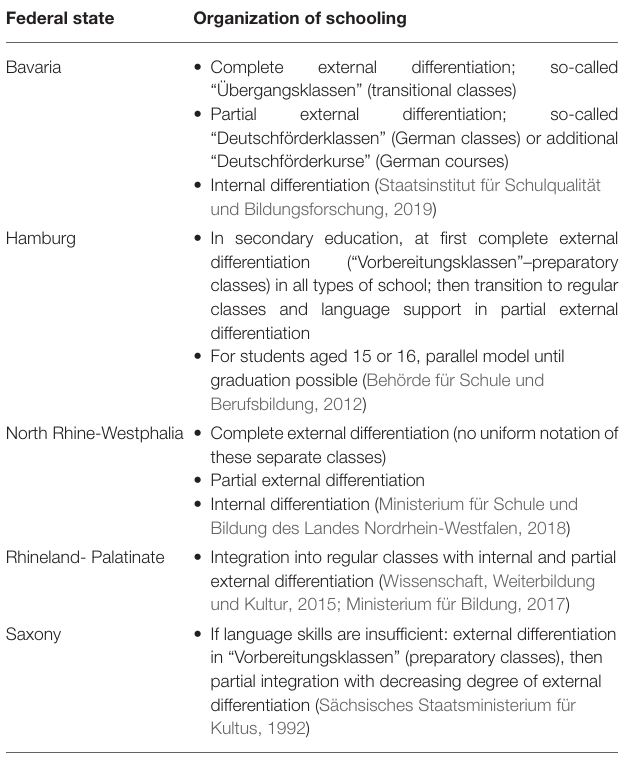
TABLE 2 | Organization of